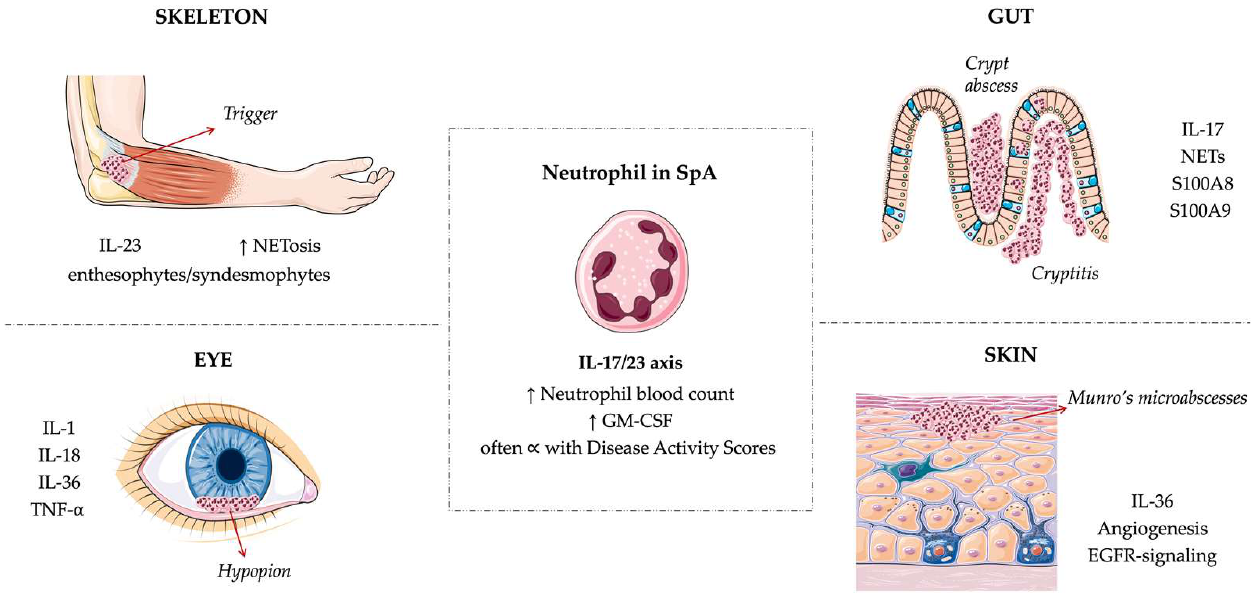
Figure 1. Legend. Neutrophils are pleiotropic cells that play a central role in the very early phase of SpA development, contributing to triggering inflammation in multiple tissues. Neutrophils are recruited from the bloodstream to target sites in Spondyloarthritis (SpA), such as joints, entheses, gut, skin, and eyes, where they produce neutrophils extracellular traps (NETs), cytokines, and chemokines to attract and activate other immune cells, boosting type 3 immunity.